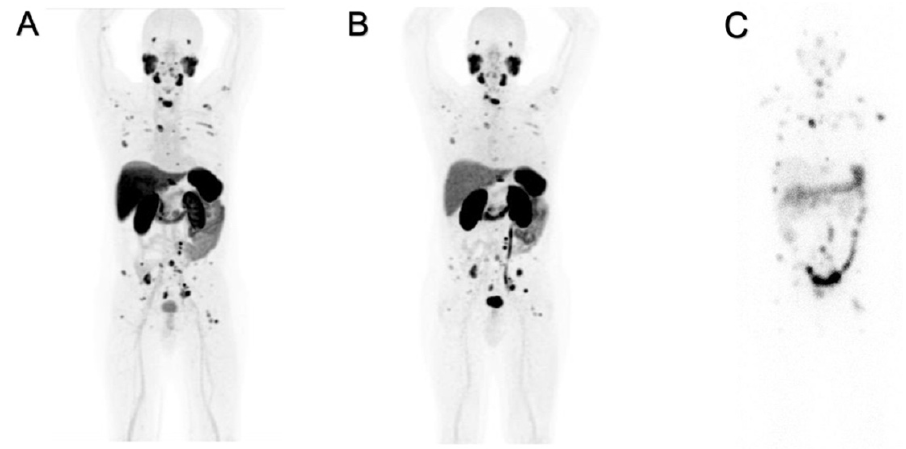
Figure 1. Positive PET/CT scans performed with ( A ) [ 18 F]PSMA-1007 (70–90 min p.i.) and with ( B ) [ 68 Ga]Ga-PSMA-11 (45–60 min p.i.) for the same patient. Planar images ( C ) acquired with SPECT/CT γ -camera 96 h after administration of [ 177 Lu]Lu ‐ PSMA ‐ 617.